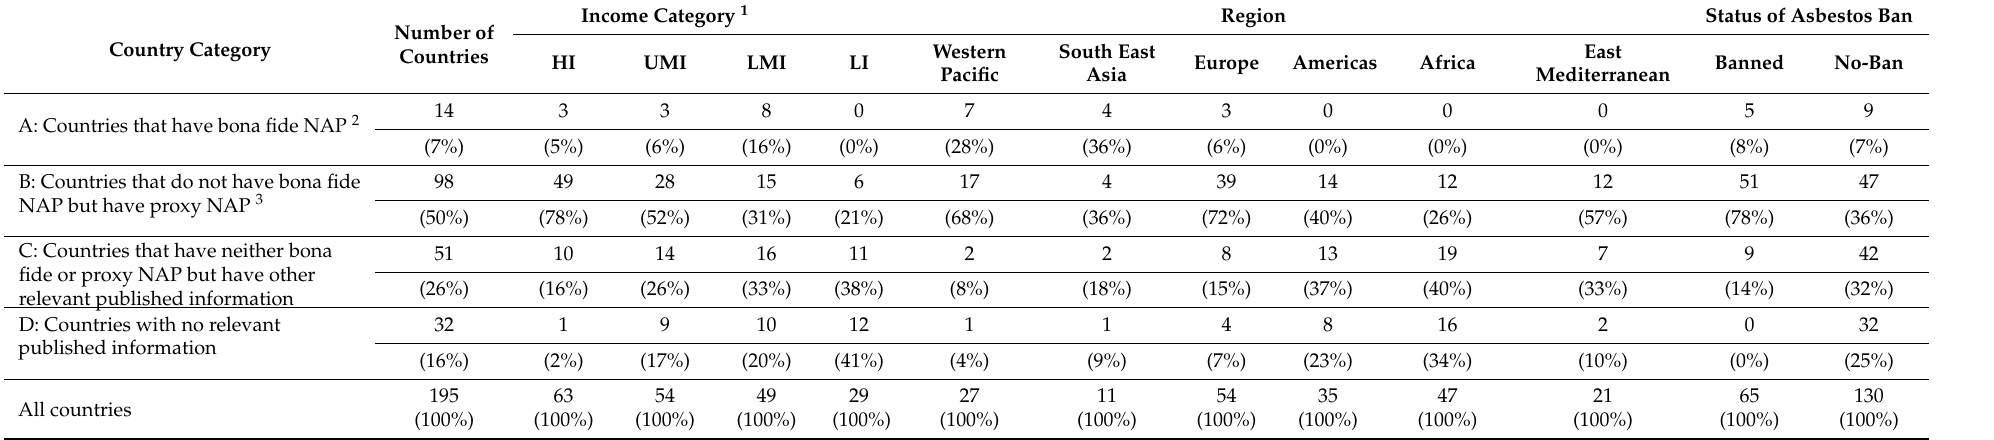
Table 2. Basic characteristics of analyzed countries by the status of their National Asbestos Profile